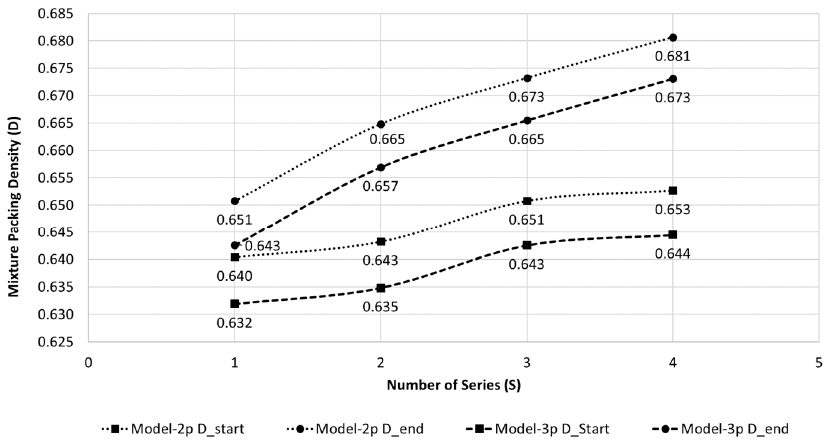
Figure 10. Variation of the mixture packing density (D) for each recycling and recompaction series computed for Model-2p and Model-3p [35,36].